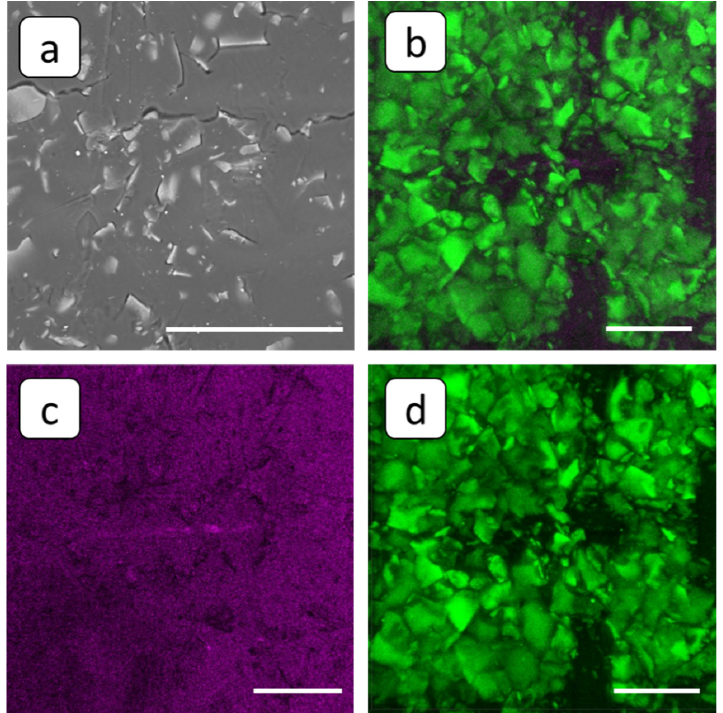
Figure 6. SEM ( a ) and FM 3D images ( b – d ) of the pristine cation-exchange membrane MK-40, superposition of fluorescent and reflected light ( b ), and the same view, separately presented in reflected ( c ) and fluorescent ( d ) light. Scale bar: 100 µm.